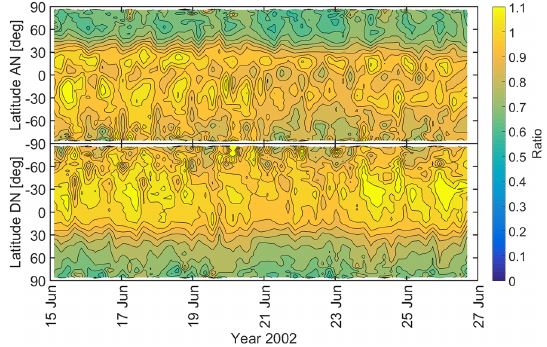
Figure 11. Density ratio (GITM / CHAMP) as a function of time and latitude for “case b” (LTAN = 22:50; LTDN = 10:50; h apogee = 449km; h perigee = 400km).